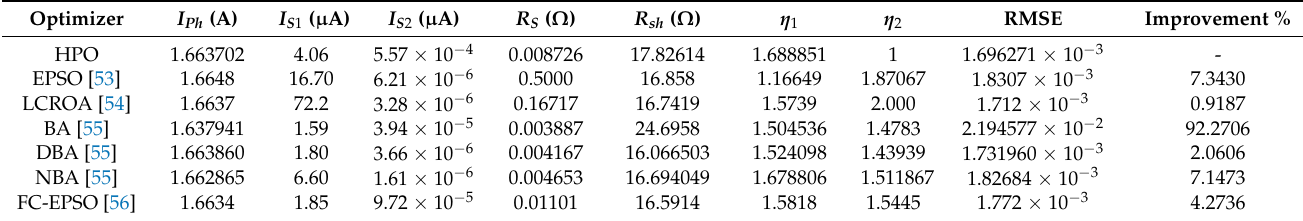
Table 3. Optimal results of the HPO and other reported techniques for the double-diode model of STM6_40/36.